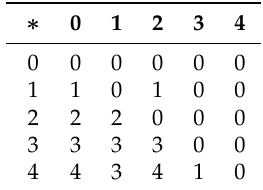
Table 1. Cayley table for the binary operation “ ∗ ”.